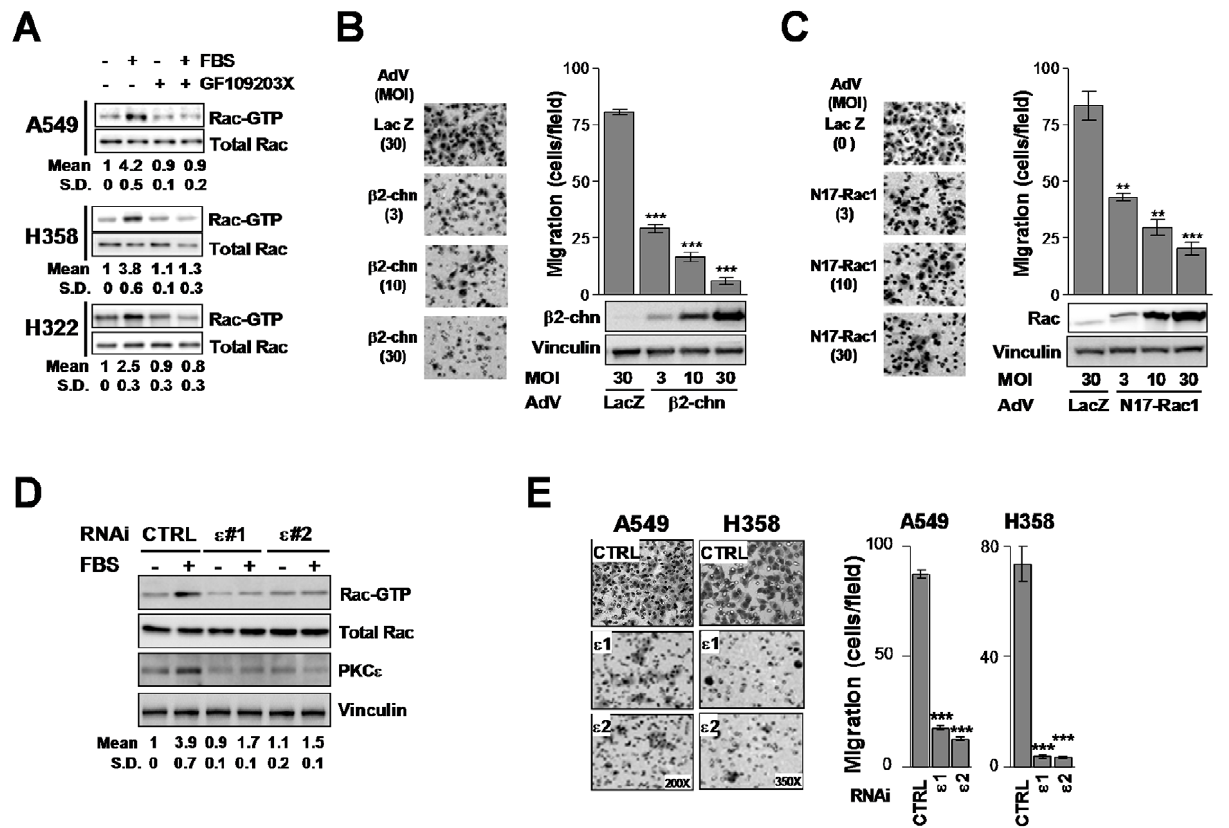
Figure 3. Rac responses induced by serum are mediated by PKC e . A. NSCLC cells were serum starved for 24 h and then incubated with 10% FBS (5 min). Rac-GTP levels determined using a pull-down assay. A representative experiment is shown and the induction of Rac, determined by densitometry, is provided at the bottom of Western blot. Data are expressed as mean 6 S.D. (n=3). B and C. A549 cells were infected with AdVs for either b 2-chimaerin ( b 2-chn ) ( Panel C ) or N17-Rac1 ( Panel D ) at the MOIs indicated in the figure. A LacZ AdV was used as control. Migration in response to FBS was assayed using a Boyden chamber for 16 h. Left panels , representative micrographs. Right panels , quantification of 3 independent experiments. Data are expressed mean 6 S.E.M. (n=3). **, p , 0.01; ***, p , 0.001. D. Rac activation by 10% FBS (2 min) in A549 cells subject to either PKC e or control RNAi, as determined using a pull-down assay. A representative experiment is shown and the induction of Rac, determined by densitometry, is provided at the bottom of each Western blot. Data are expressed as mean 6 S.D. (n=3). E. Migration of A549 and H358 cellssubject to either PKC e or control RNAi in response to 10% FBS (16 h) using a Boyden chamber. Left panels , representative micrographs. Right panels , quantitation of 3 independent experiments. Data are expressed mean 6 S.E.M. (n=3). **, p , 0.01; ***, p ,